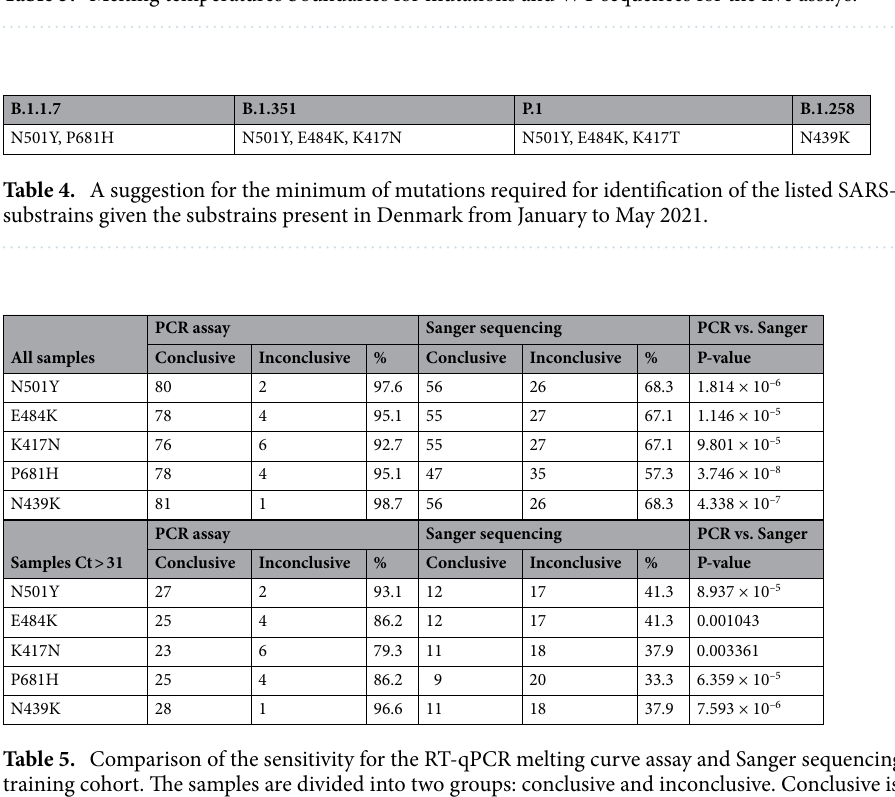
Table 3. Melting temperatures boundaries for mutations and WT sequences for the five assays.